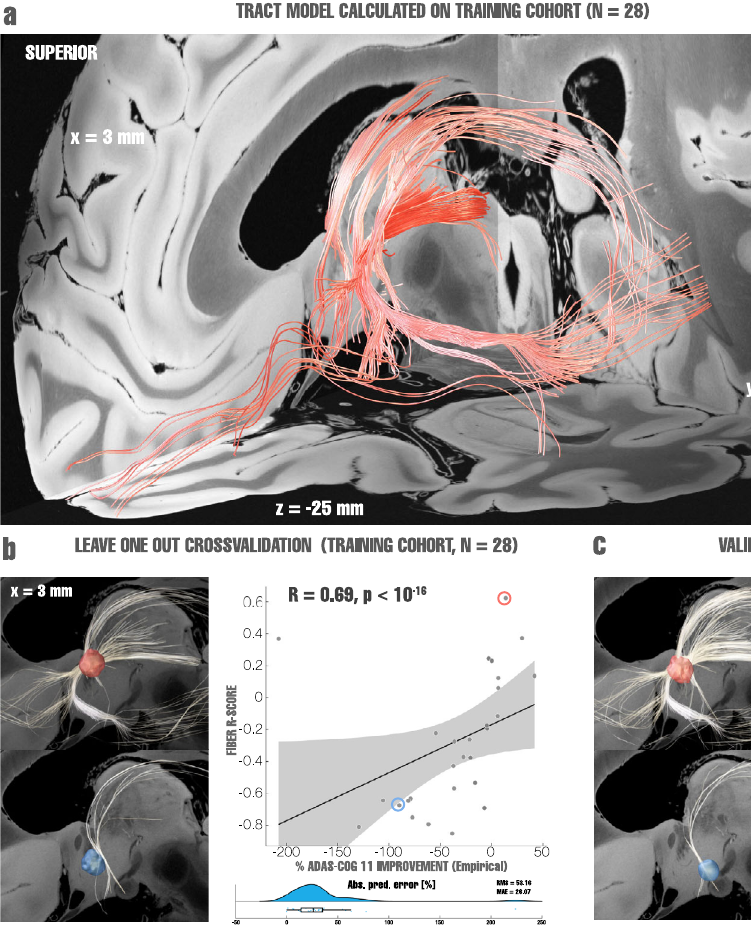
nected(white) fi bers.The two example patients are marked in the correlation plot with circles. Right: Spearman correlation between the degree of stimulating posi- tivelycorrelatedtractsfromthetrainingcohortbythehold-outcohortandclinical improvements of the latter,grayshadedareasrepresent 95%con fi